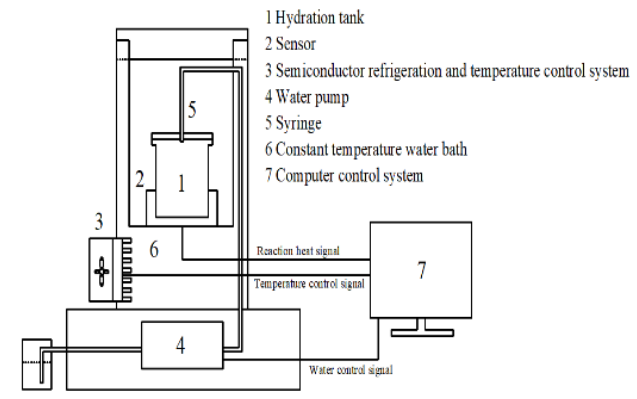
Figure 3. Automatic cement hydration heat tester.